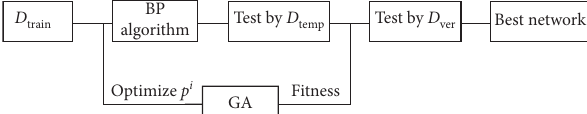
Figure 2: Structure of the